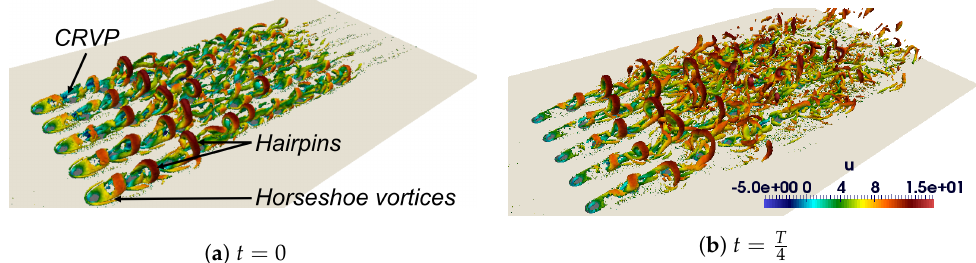
Figure 6. Isosurface of Q criterion coloured by the axial velocity (m.s − 1 ), during the ejection mid-period.